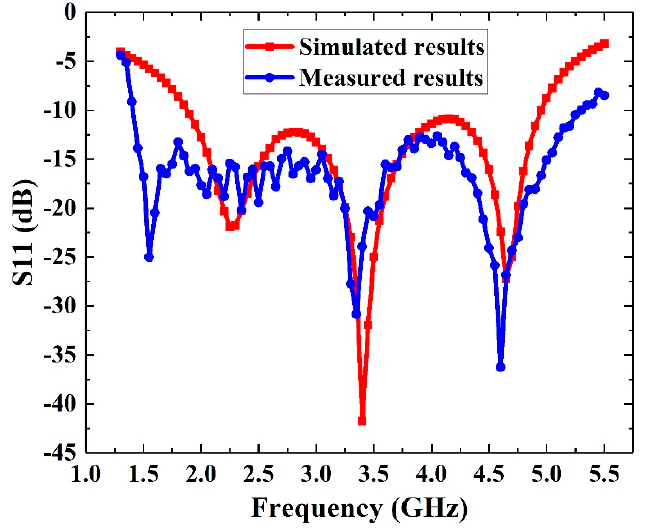
Figure 8. Comparison between simulated and measured results.